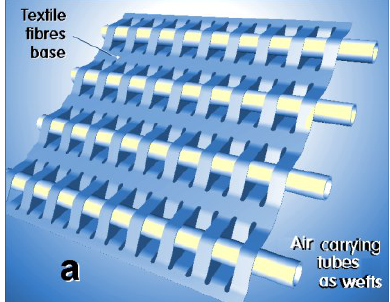
Fig. 1. Earlier idea of cooling textile. Interwoven small tubes for flow of air cooled by